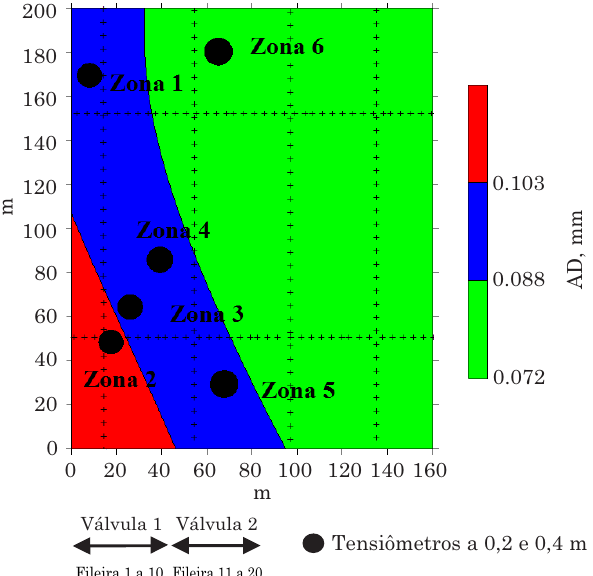
Figura 6. Zonas de manejo de irrigação determinadas, levando-se em conta as zonas homogêneas do solo e a subdivisão do sistema de